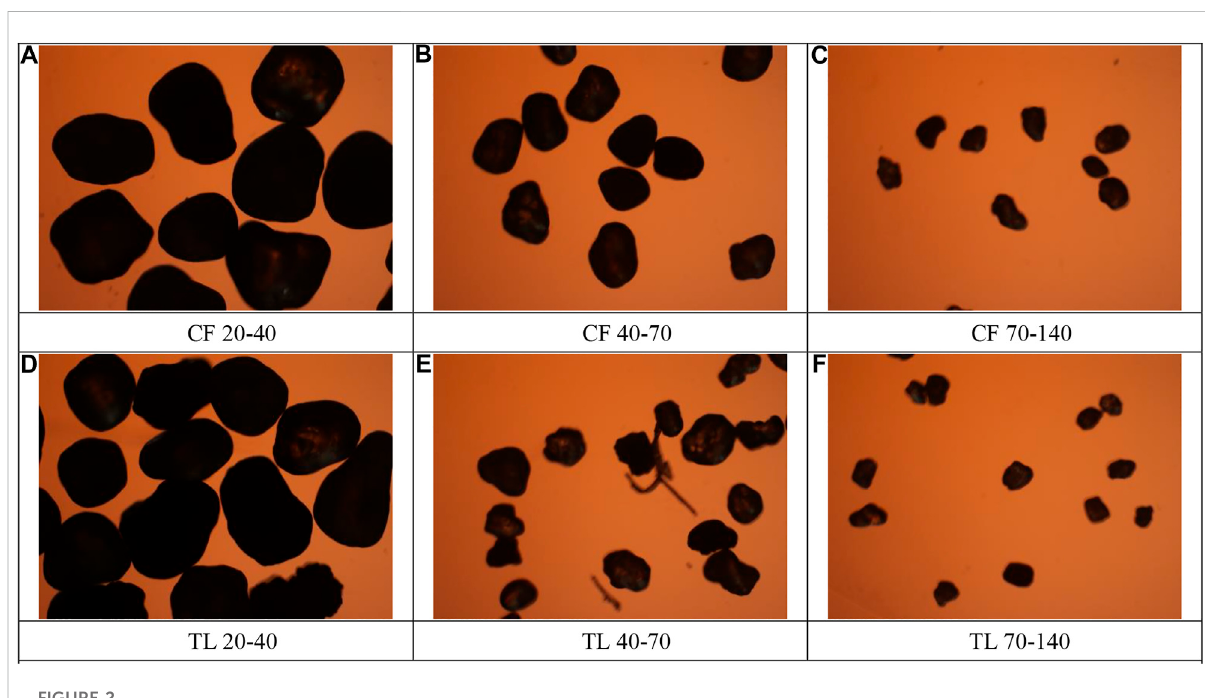
FIGURE 2 Microscope picture of each proppant under the